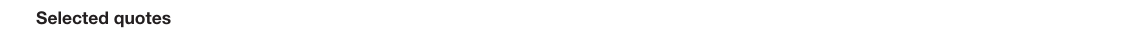
TABLE 3 | Selected quotes from students’ and experts’ verbal reports.